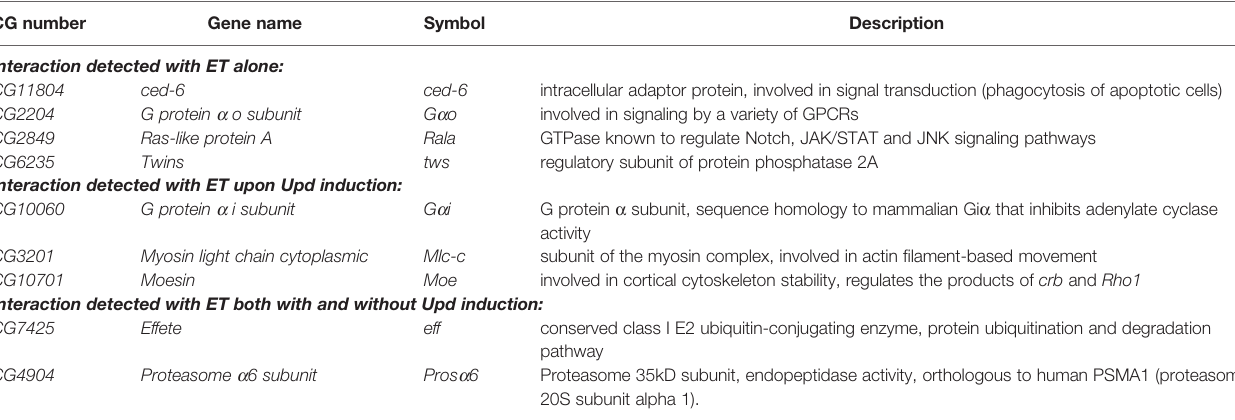
TABLE 1 | Selected putative ET interaction partners from the mass spectrometry